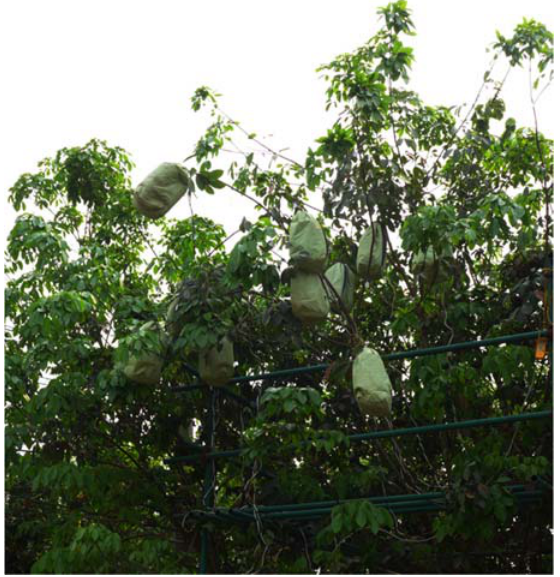
Figure 3. High temperature treatment with a heating device to Hevea brasiliensis MFBs during microsporogenesis induce microspore chromosome doubling.